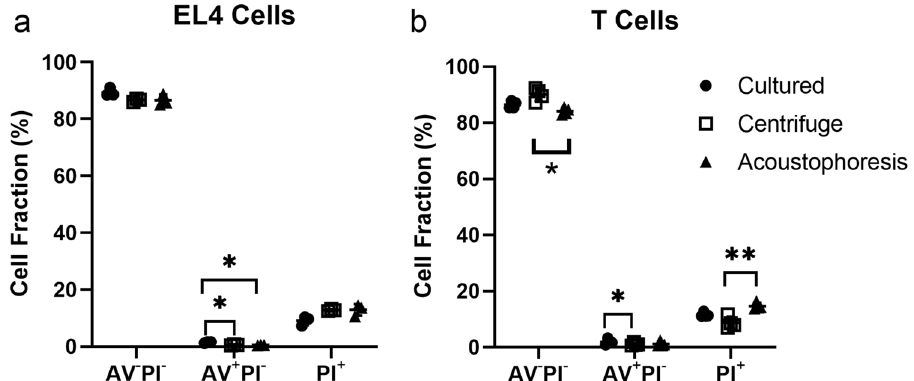
Figure 5. Annexin V (AV) and PI staining of the EL4 cells ( a ) and T cells ( b ) in the original cell culture (cultured) and after full 89 Zr-oxine labeling procedure using centrifugal (centrifuge) and acoustophoresis methods, analyzed with flow cytometry (n = 3). The AV − PI − cells are considered viable, while the AV + PIs − cells are early apoptotic, AV − PI + and AV + PI + cells (PI + ) are necrotic or late apoptotic. Only statistically significant differences between samples are annotated in the plots (n = 3, * P < 0.05, ** P < 0.01). Plots show mean ± SD for each set of N measurements.